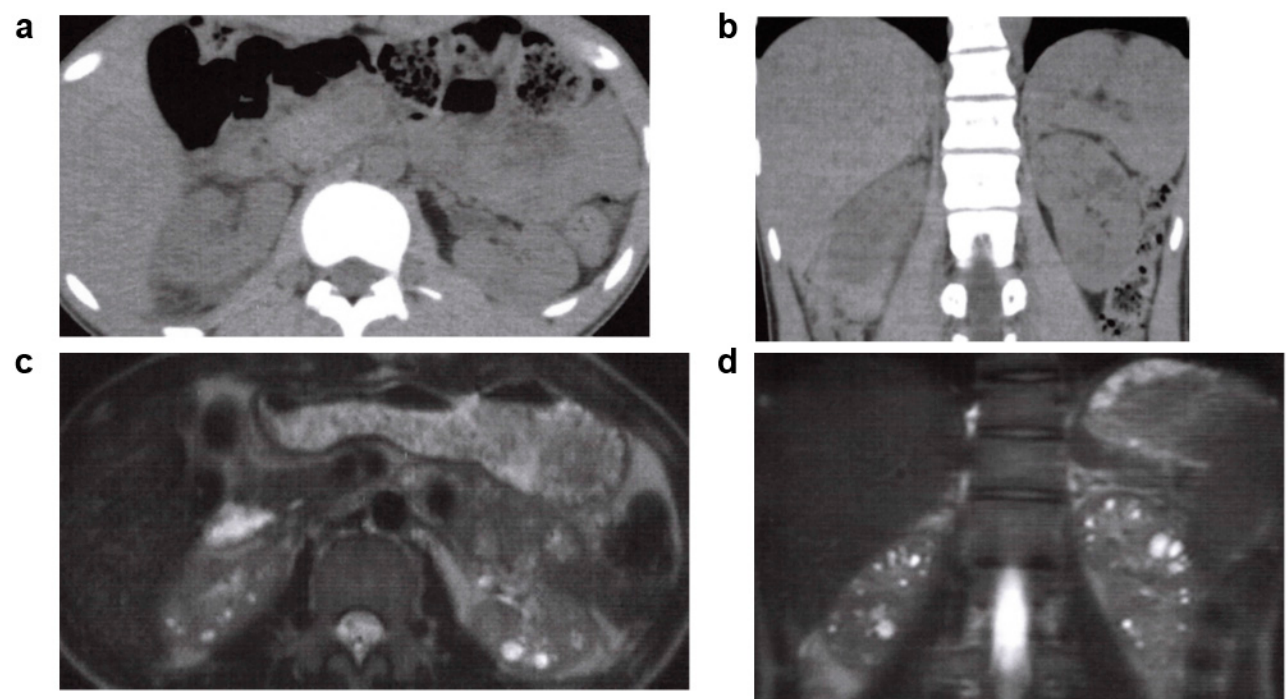
Figure 7. Autosomal dominant tubulointerstitial kidney disease (ADTKD): 20s, male, UMOD gene heterozygous mutation, positive for familial hyperuricemia, no family history of polycystic kidney disease or end-stage kidney disease, no history of cerebral aneurysm or heart valve disease, began dialysis at age 20 years (image provided by Toranomon Hospital). ( a ) Non-contrast CT image (horizontal section): many cysts in both kidneys, but there is no kidney enlargement. ( b ) Non- contrast CT image (coronal section): many cysts in both kidneys, but there is no kidney enlargement. ( c ) MRI T2-weighted image (horizontal section): many hyperintense cysts in both kidneys, but there is no kidney enlargement. ( d ) MRI T2-weighted image (coronal section): many hyperintense cysts in both kidneys, but there is no kidney